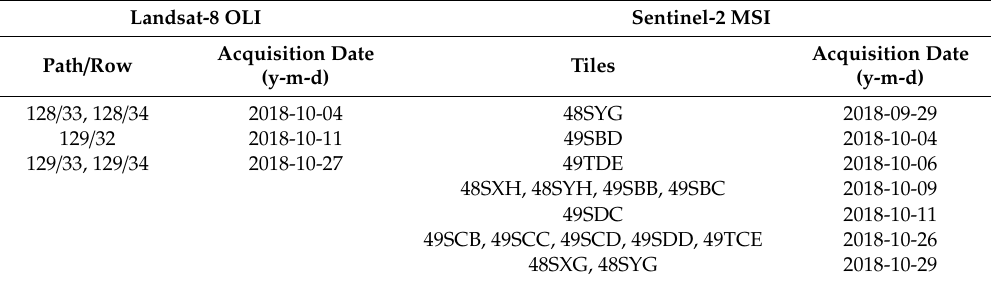
Table 2. Overview of satellite scenes applied in this